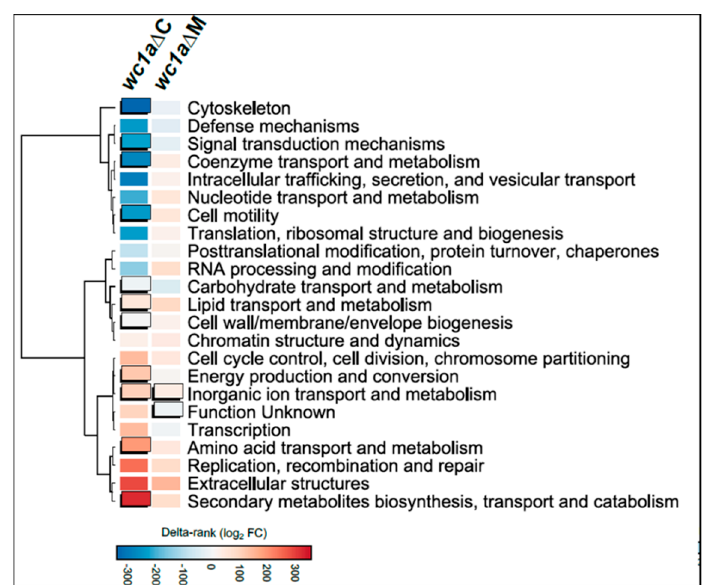
Figure 3. Significant genes during regular growth ( wc1a Δ c) and macrophage phagocytosis ( wc1a Δ M) were analyzed for Eukaryotic Orthologous Groups (KOG) class enrichment. Significant enrichments (Fisher’s exact test, p ≤ 0.05) are shown as uplifted rectangles. A measure of up- or down-regulation for each KOG class is indicated according to a colored scale of delta-rank values (the difference between the mean rank differential expression value of all genes in a particular KOG class and the mean rank differential expression value of all other genes). KOG classes are clustered according to the similarity of their delta rank values.